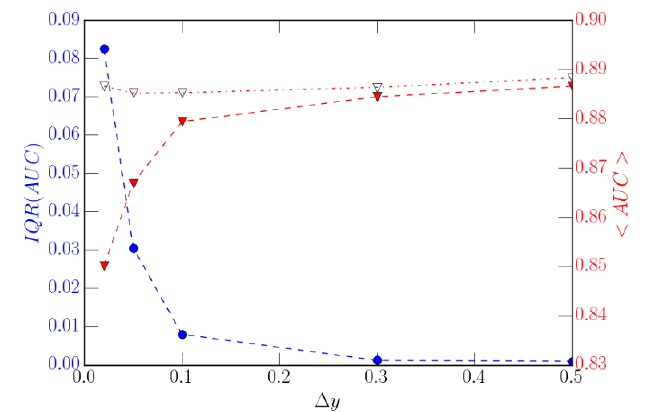
Figure 2 . Median (solid triangles) and interquartile range (solid dots) of the AUC as a function of the di(cid:11)erence in proportions (cid:1) y between the two subsets of the training sample. The proportion corrisponding to one subset is (cid:12)xed to 0.2, while the other varies. For each point the AUC is computed 100 times on the same test set with di(cid:11)erent trainings, each performed with a random weight initialization. The maximum AUC for each point is also shown (hollow